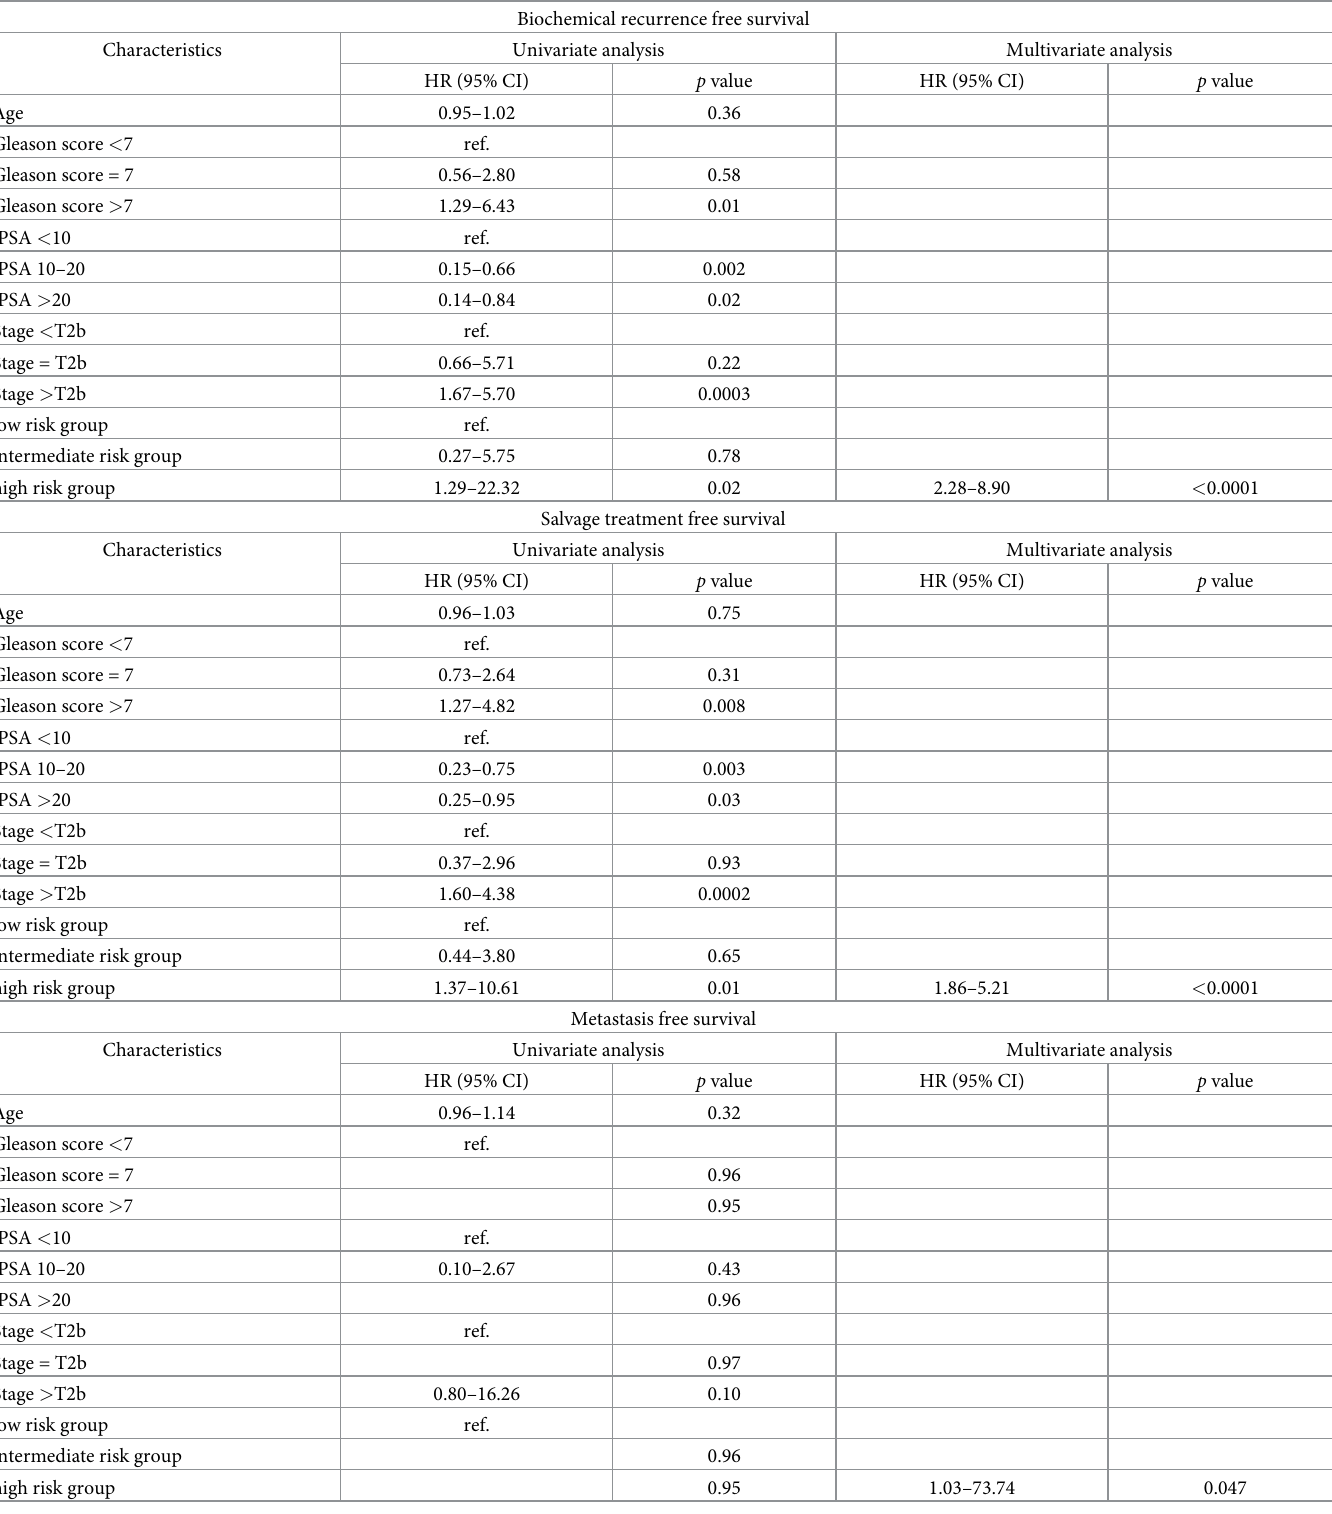
Table 3. Cox regression multivariate analysis for oncologic outcome after primary